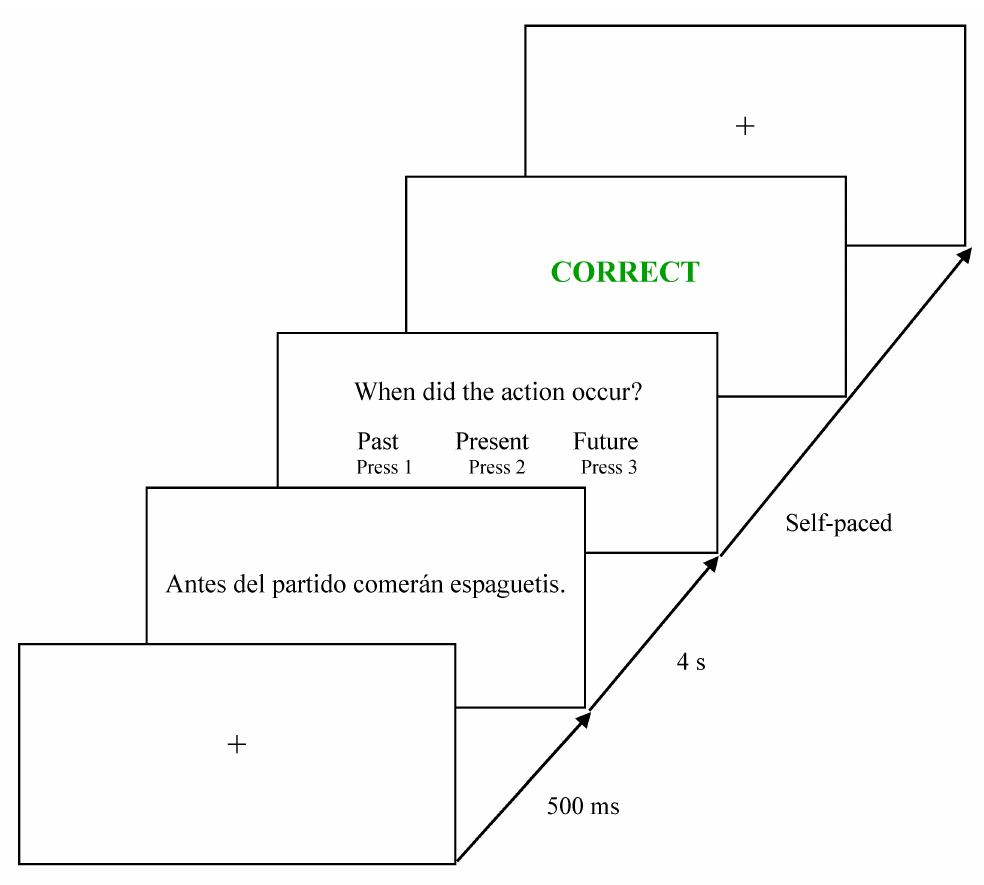
Figure 2. Example of a Training Visual Trial with a Tense